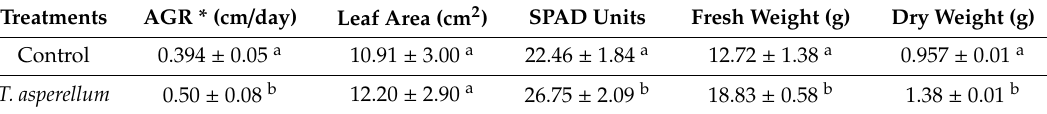
Table 1. E ff ect of T. asperellum on plant growth of tomato plants. Absolute growth rate, leaf area, SPAD units, fresh and dry weight of tomato plants after 40 days of T. asperellum inoculation are shown.